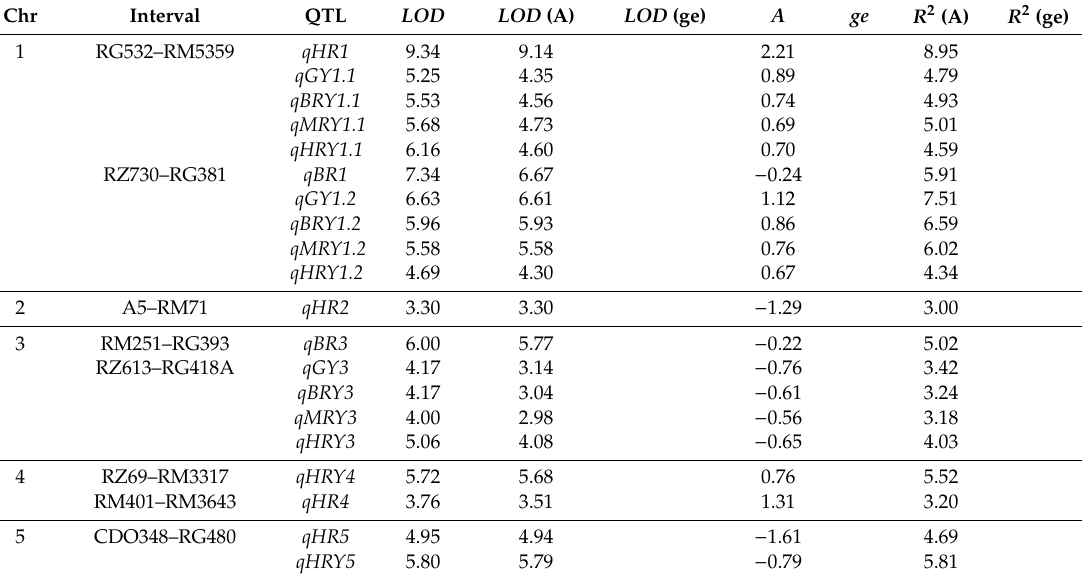
Table 3. QTLs for seven traits detected in the ZM